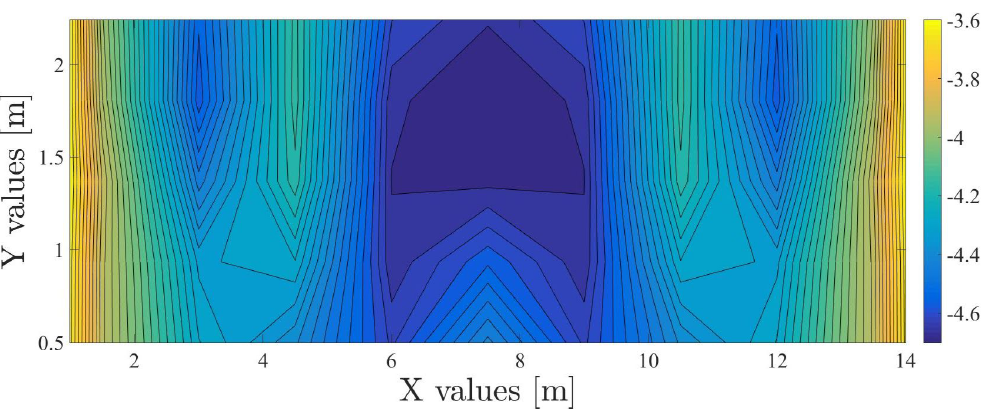
Figure 13. Mapping of the maximal displacement reached by the block centre as a function of the impact position on the net (m) for an impacting energy E M , ini of 270